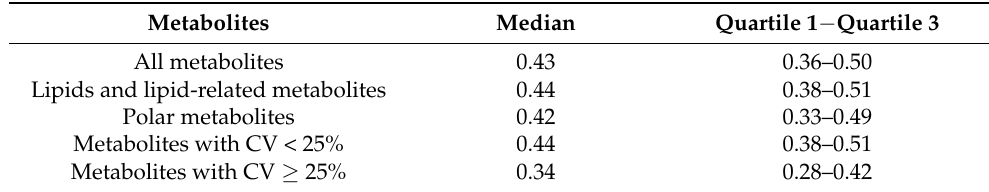
Table 1. Intra-class correlations (ICC) among 295 metabolites, by metabolite subsets, in the primary dataset.